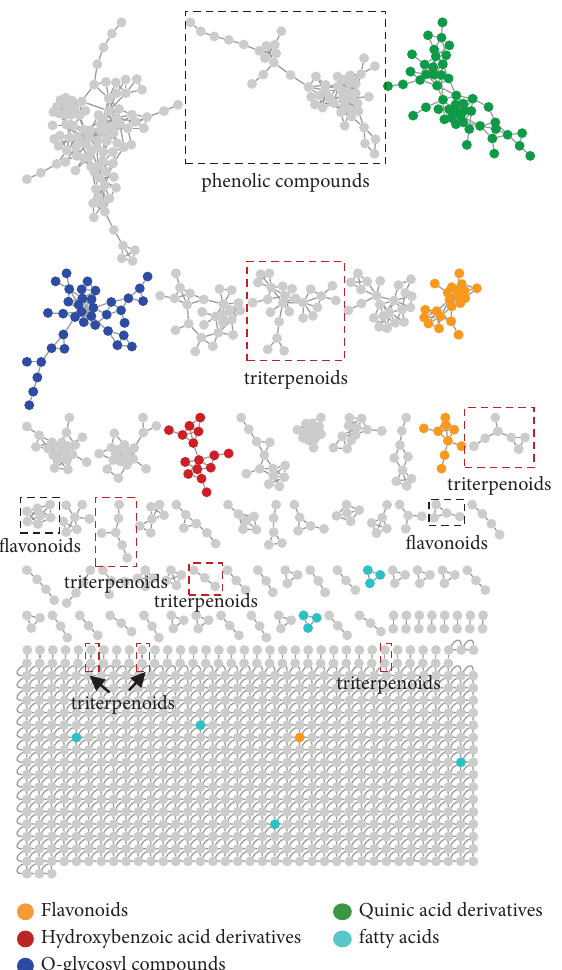
Figure 4: Te global molecular networking of antioxidant extracts of LCP. Te chemical classes of nodes, flled with diferent colours except for grey, were annotated by MolNetEnhancer. Te structure classes of part nodes marked with grey and with a dashed box were annotated by an in-house database together with their MS 2 spectra. Te structure classes of rest nodes with grey colour are not annotated in present